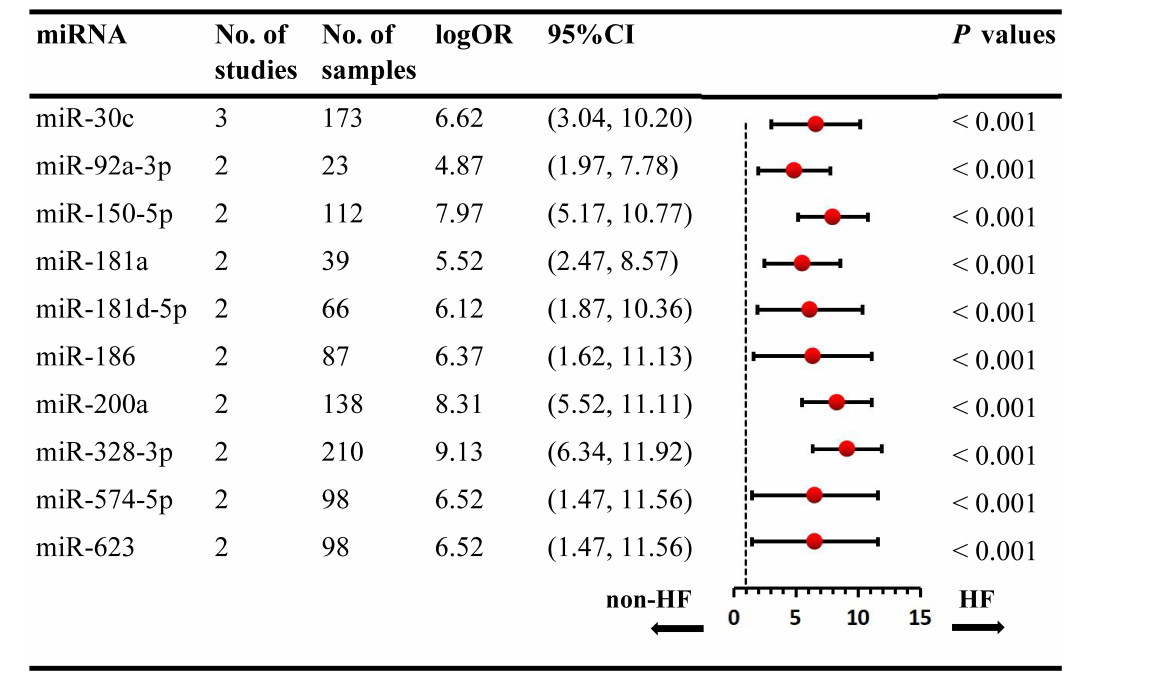
FIGURE 4 | Statistically significant down-regulated miRNAs in overall analysis. miR, microRNA; No, number; HF, heart failure.